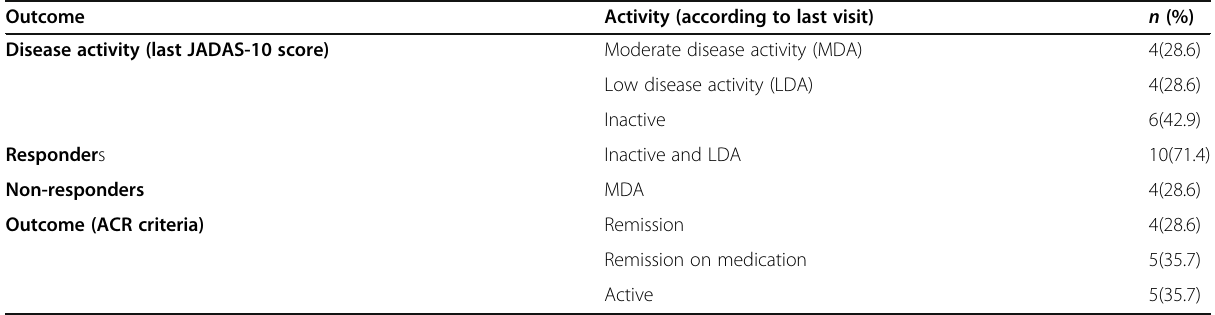
Abbreviations : JADAS Juvenile Arthritis Disease Activity Score, ACR American College of